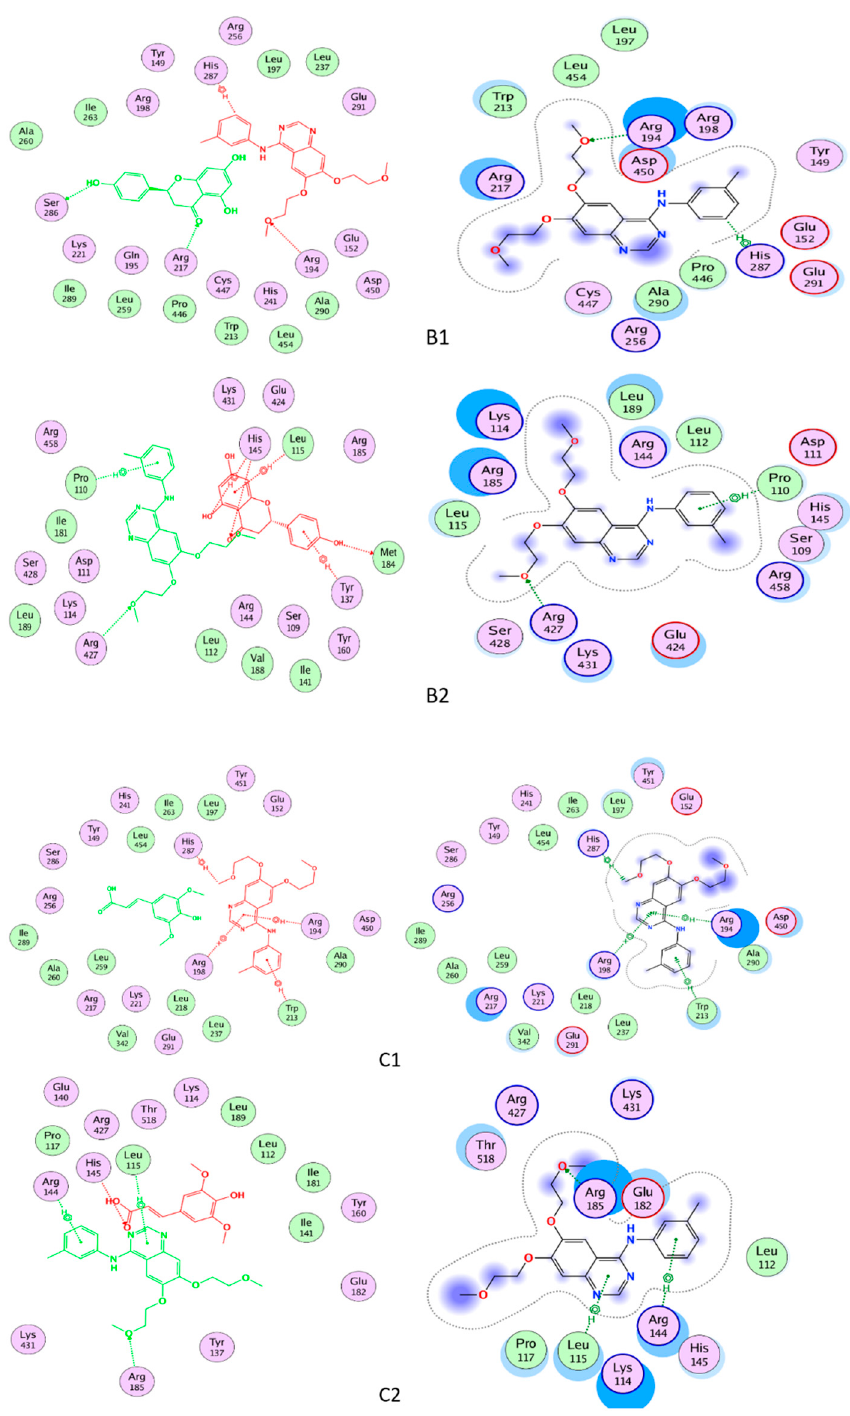
Figure 7. Two-dimensional molecular-docking conformation for BSA ETB. In presence of RUT, ( A1